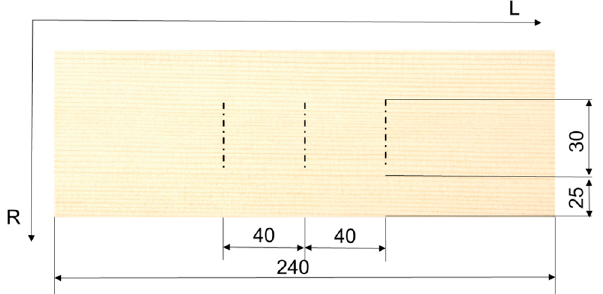
Figure 3. The measuring principle for the surface morphology of the samples. Values in mm.